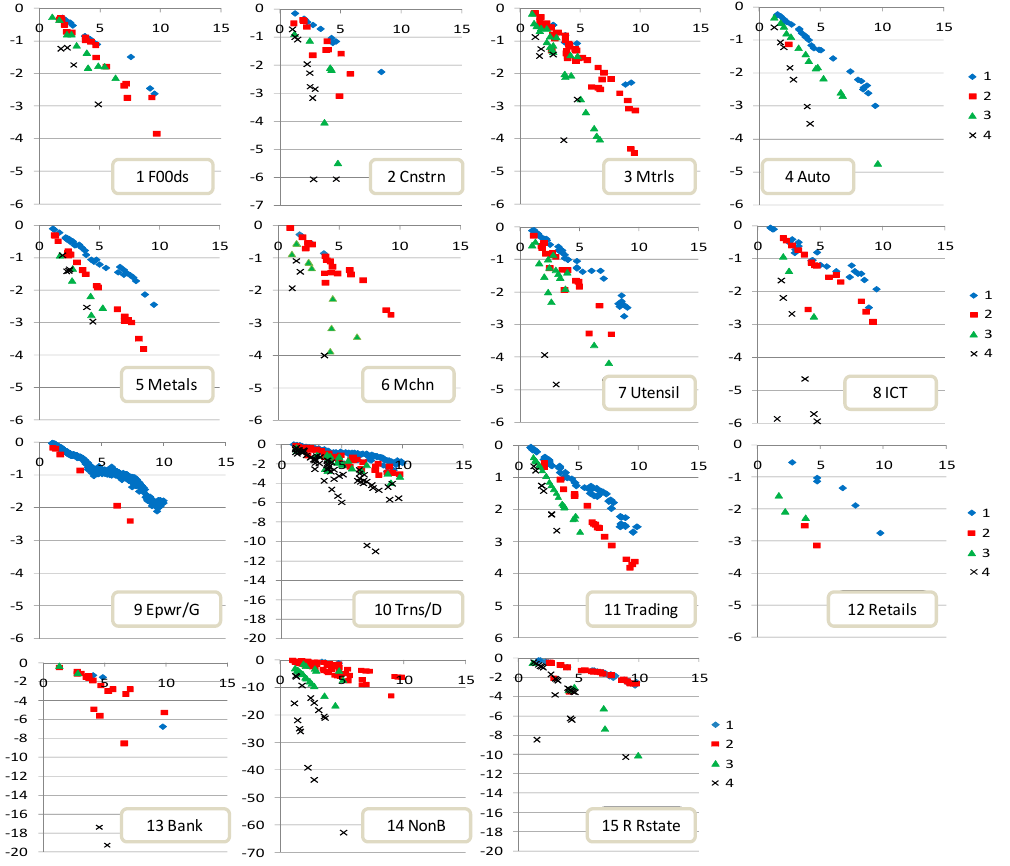
Figure 6. Industry-wise CRIPS-plots of the four groups via R&I ratings.